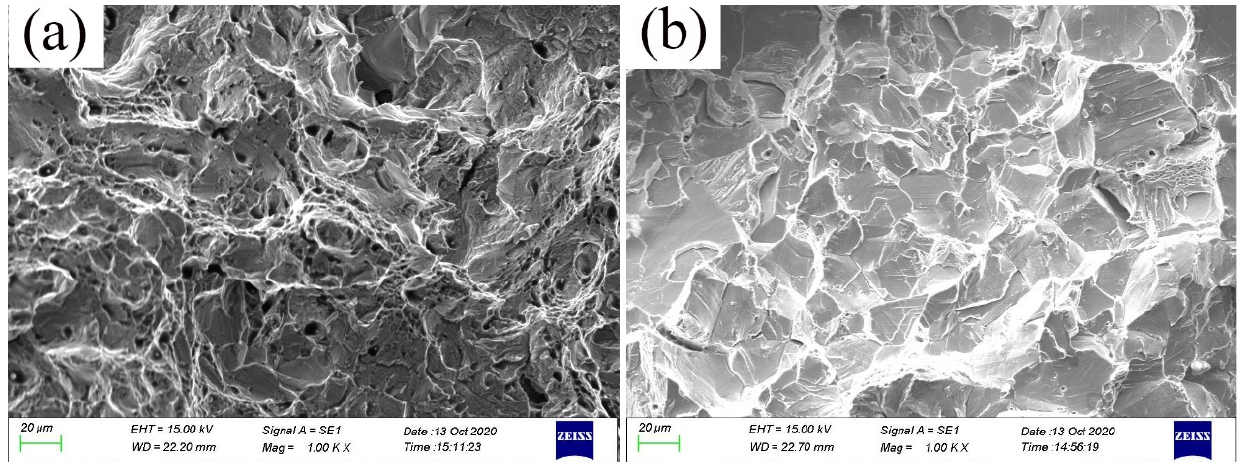
Figure 7. The Charpy impact fracture morphology characterized by SEM of samples with 11% Al addition under water quenching ( a ) and furnace cooling ( b ).